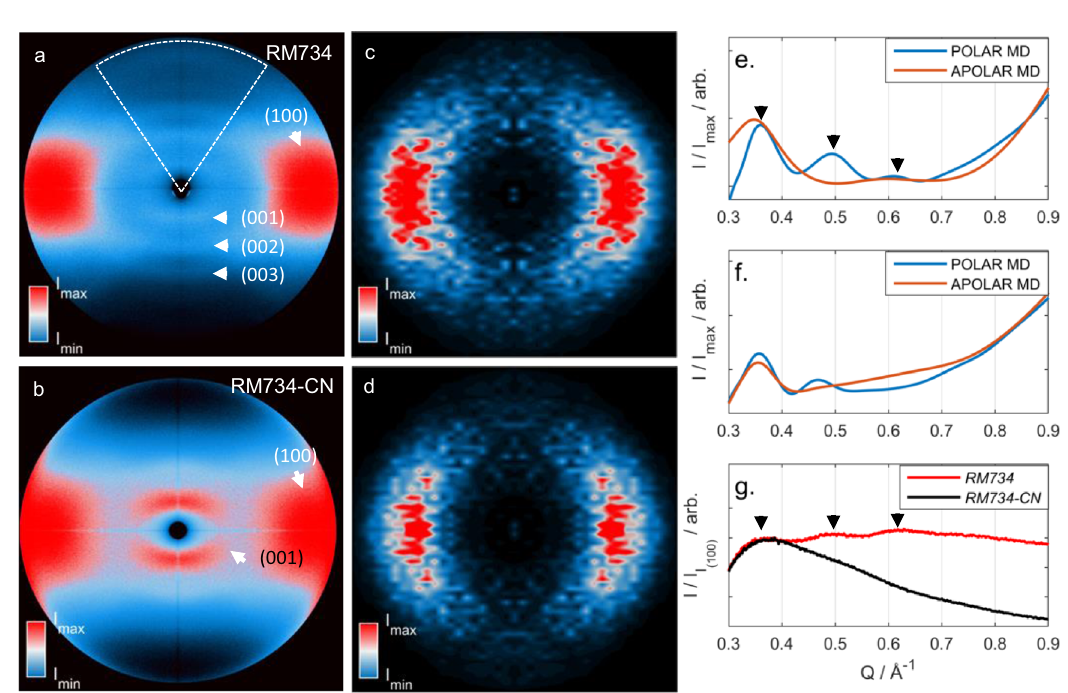
Fig. 6 X-ray scattering. Magnetically aligned two-dimensional X-ray scattering patterns for a RM734 and b RM734-CN in the nematic phase at 152 and 158 °C, respectively. Simulated 2D X-ray scattering patterns obtained from MD trajectories for RM734 with polar ( c ) and apolar ( d ) nematic organization, as described in the text. Calculated small-angle X-ray scattering intensities (Icalc) versus Q (Å − 1 ) for MD simulations with parallel and antiparallel dipole organisation for RM734 ( e ), and RM734-CN ( f ). g Experimental small-angle X-ray intensities ( I / I max ) versus Q (Å − 1 ) for RM734 (red solid line) and RM734-CN at 130° (black solid line). In ( a ), the dashed lines show the region that was radially integrated to obtain the data presented in ( g ); in ( e ) and ( g ), arrows are a guide to the eye and indicate the 001, 002 and